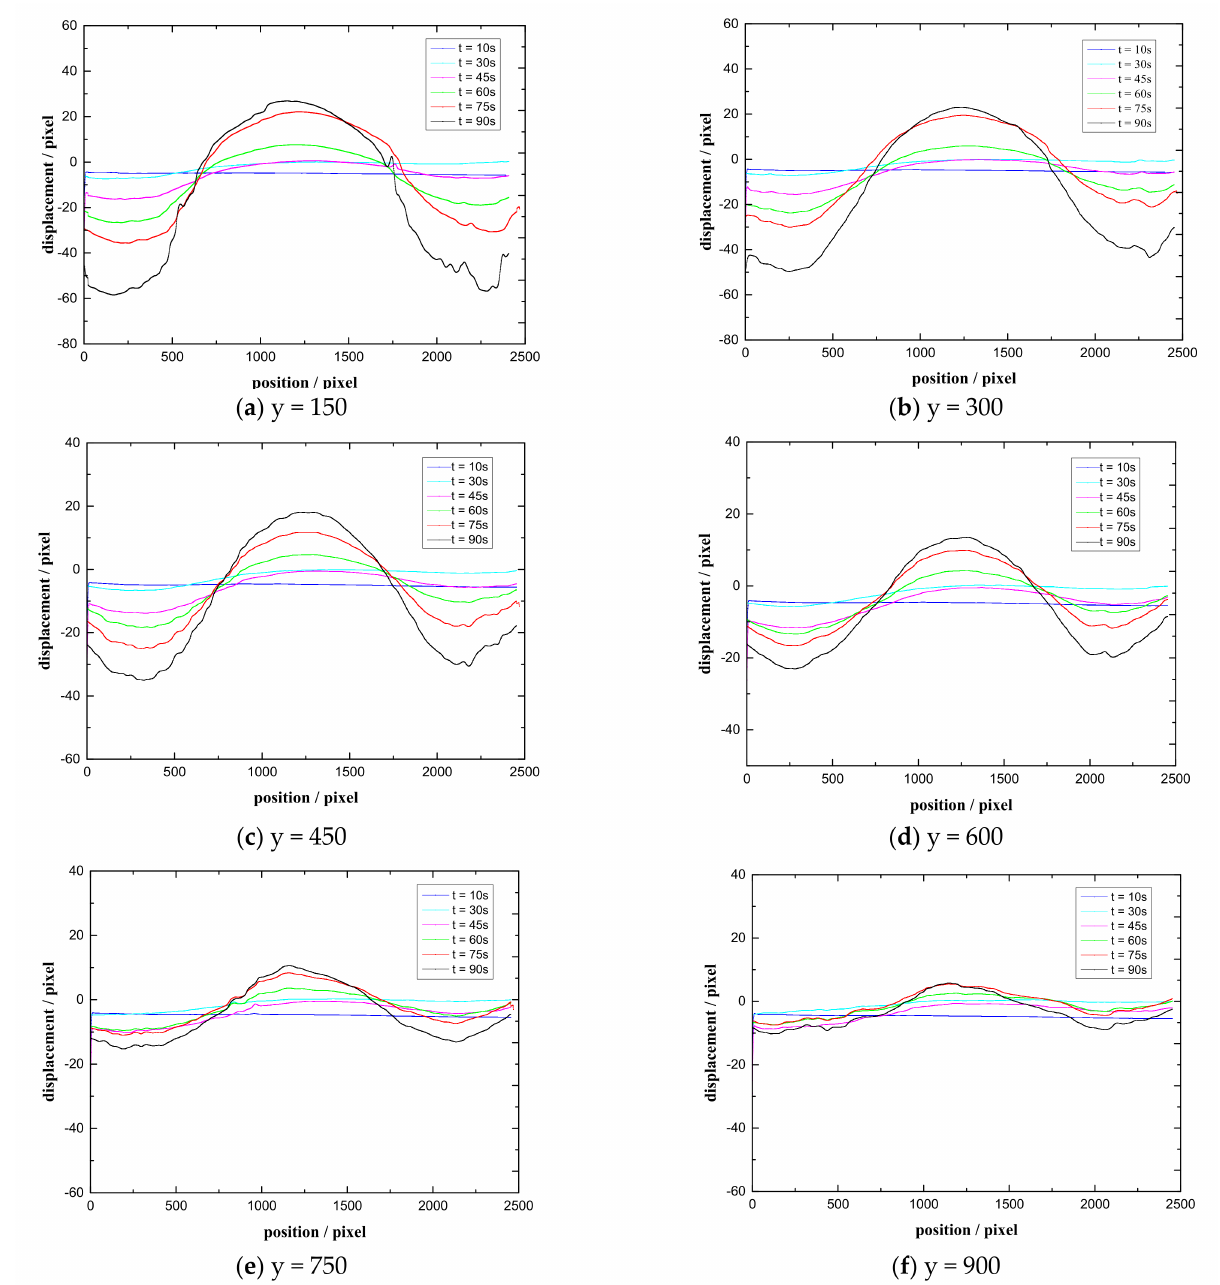
Figure 5. Deformation in different horizontal sections at different